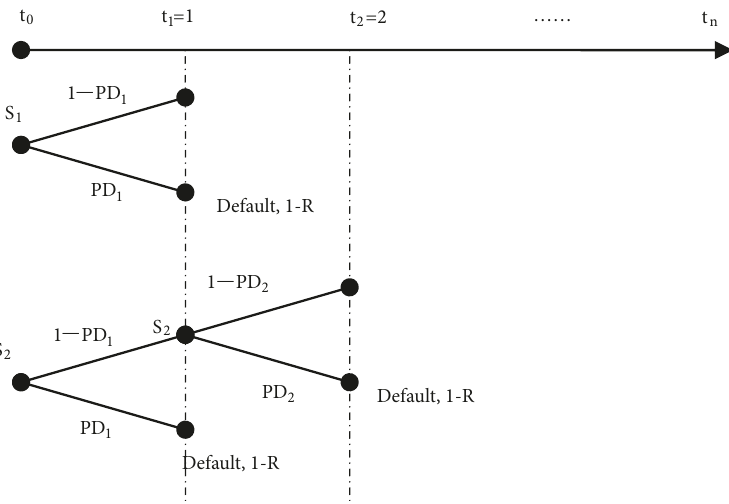
Figure 4: Binary tree-CDS pricing solution (premium payment in